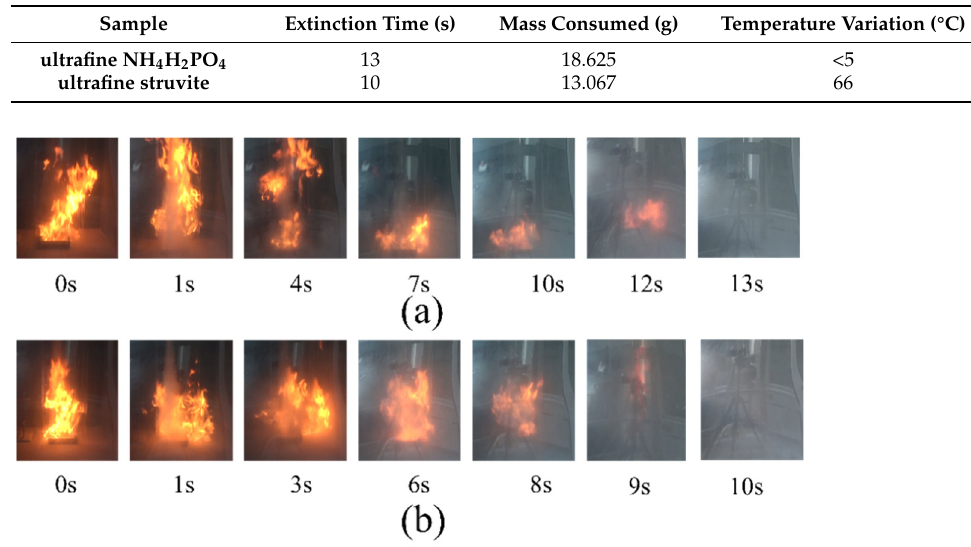
Table 2. Extinguishing performance and Temperature drop.